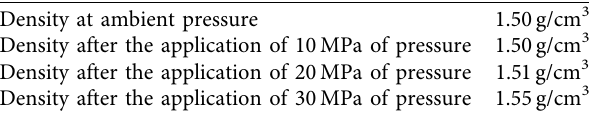
Table 4: Density of the cement slurry system at different pressures.